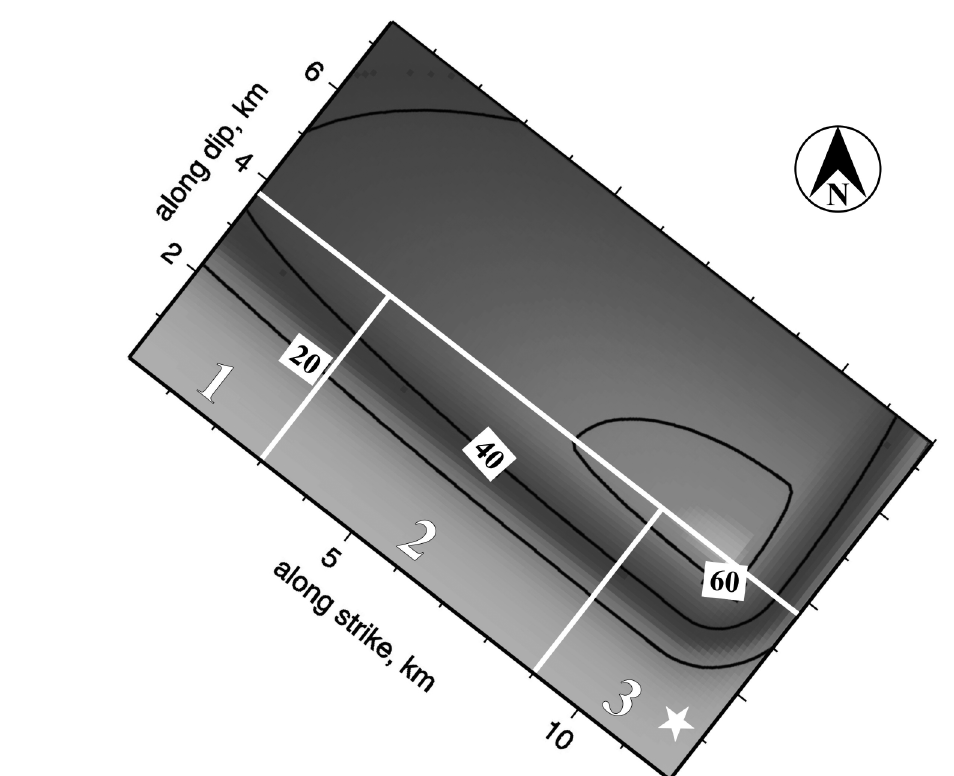
Fig. 2. Final slip distribution for the Colfiorito earthquake is represented as contour black lines. The units are cm. The white star represents the position on the fault of the earthquake hypocenter. It is also shown (as white lines) the subdivision of the bottom half of the fault considered to name the different rupture processes. Nucle- ation points falling in the zone 1, 2, and 3 produce a SE unilateral, bilateral, and NW unilateral directivity, re-